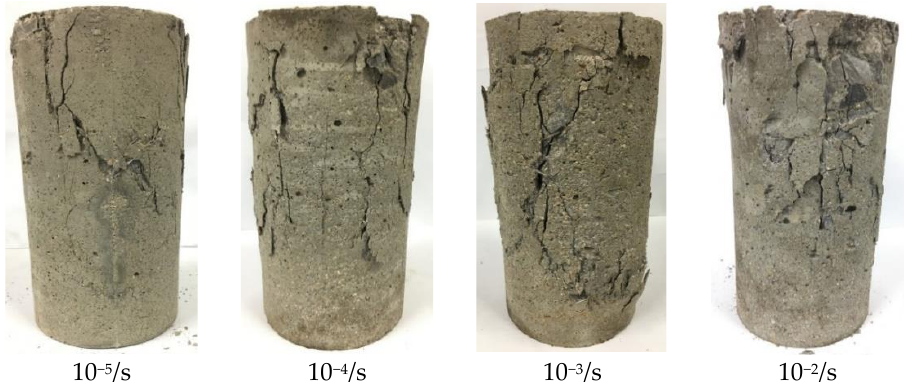
Figure 15. Typical failure modes of SF10 specimen with 0 MPa confining pressure at different strain rates.